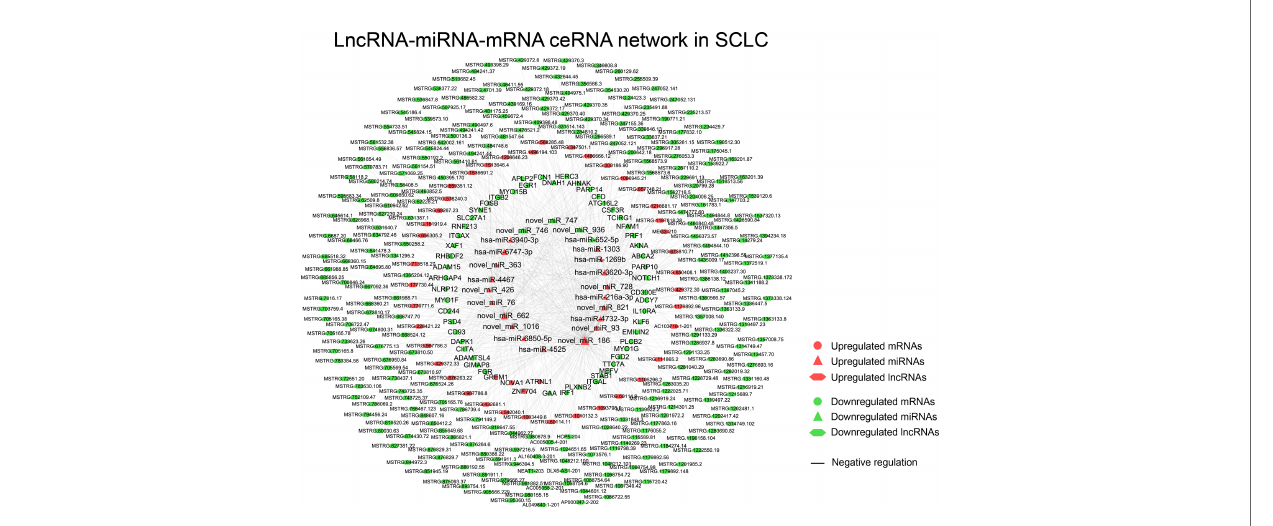
FIGURE 3 | The lncRNA-miRNA-mRNA ceRNAs network in SCLC. lncRNA, long noncoding RNA; miRNA, microRNA; mRNA, messenger RNA; SCLC, small cell lung cancer.